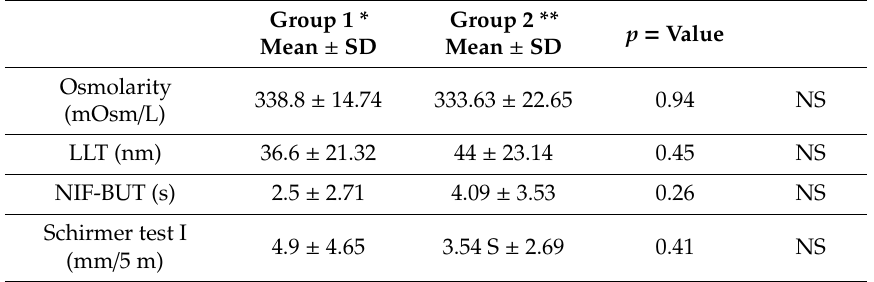
Table 3. Values of lipid tear dysfunction in fertile (Group 1) and postmenopausal women (Group